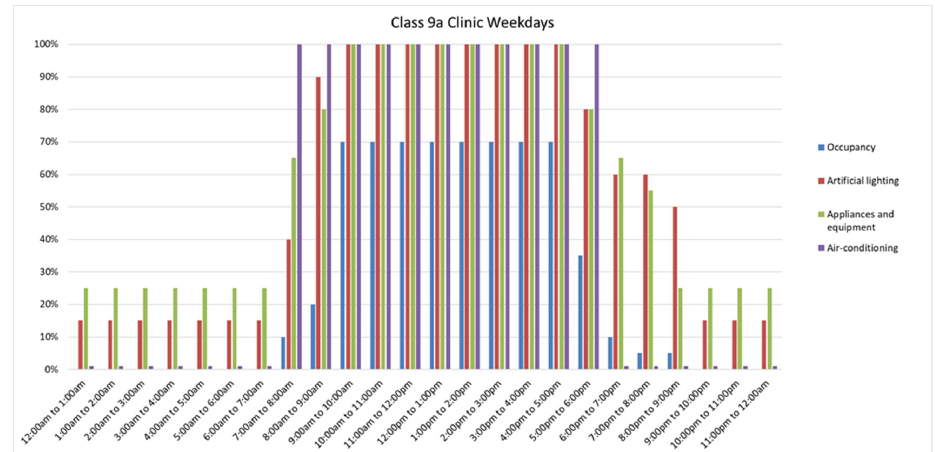
Figure 6. Operation schedules for “Class 9a Clinic”—weekdays.